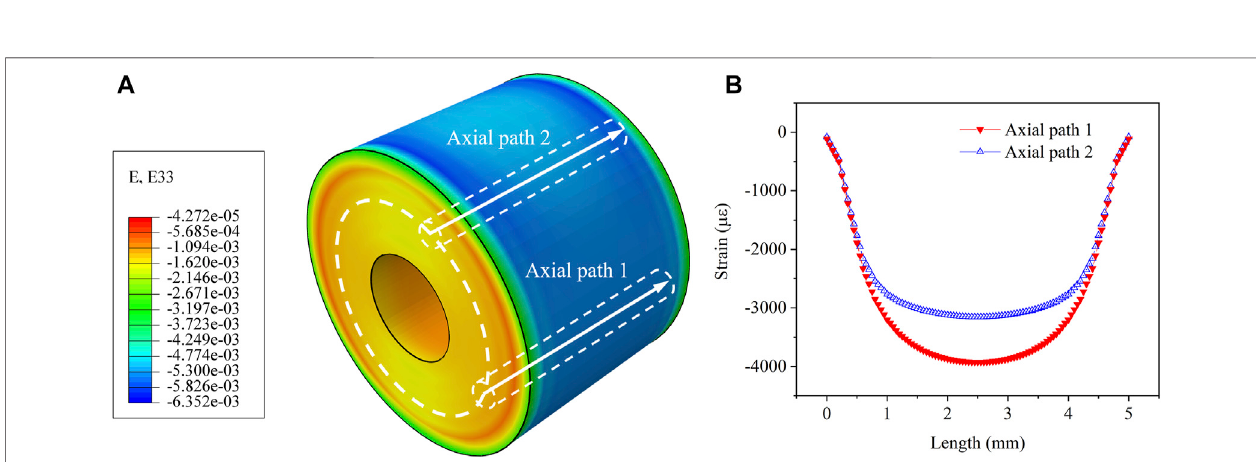
FIGURE10 |(A) Contourofthe compressive strain of thedesigned model; (B) large-gradient nonuniform strain distribution along tworadial paths in glass with the thickest and the thinnest metal shell.